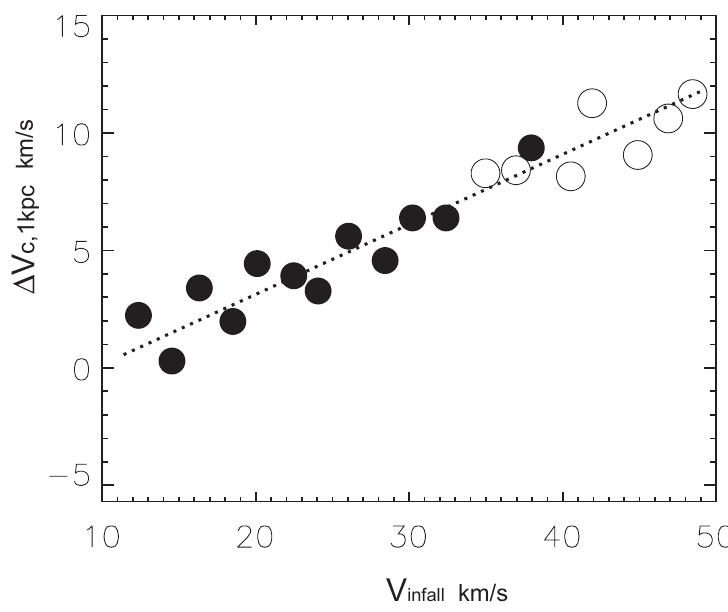
Figure 15. Flattening of satellites from inner Baryonic tidal stripping and heating, expressed in terms of difference in central v c at 1 kpc, and z = 0, between equivalent DMO, and DMB satellites as a function of equivalent DMO satellites maximum velocity v max at infall. The model produces, for satellites with M b / M 500 < 0.01, filled circles, while for M b / M 500 > 0.01, the open circles and results in a linear fit (dashed line) (figure reproduced from